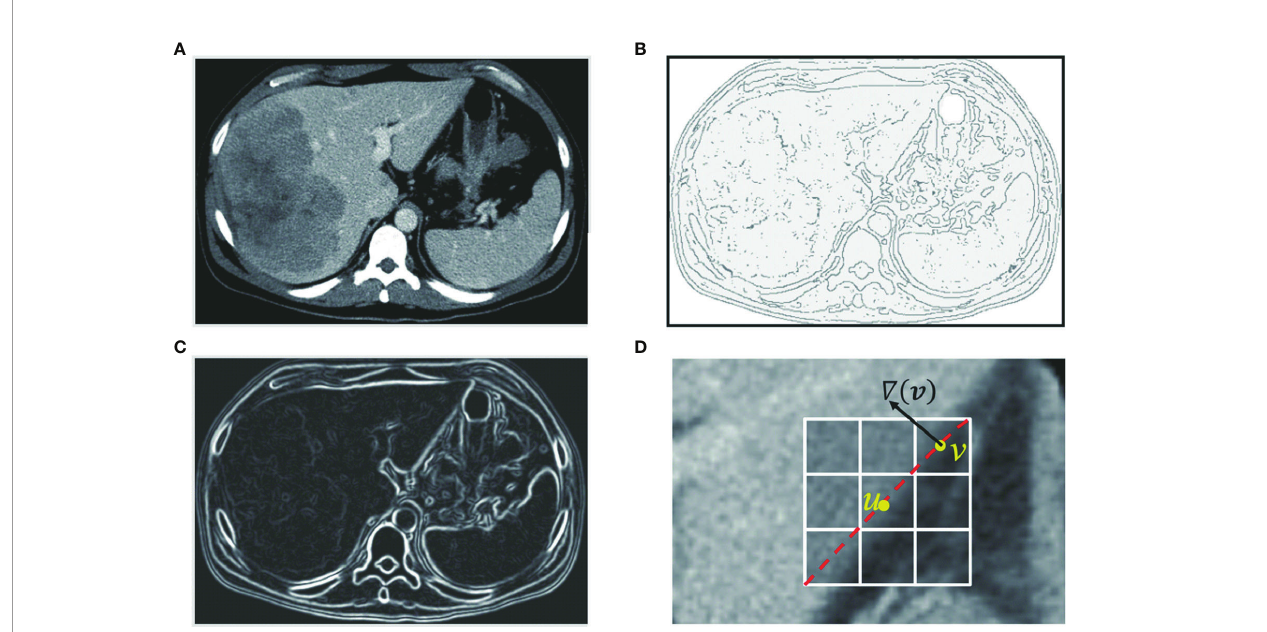
FIGURE 3 | Edge features such as zero-crossing and gradient are incorporated into the computation of local cost. (A) Original axial image. (B) Zero-crossing: points with local maximal gradient magnitude corresponds to a local boundary point with lower cost. (C) Gradient magnitude: a point with a large gradient magnitude tends to indicate a local boundary and thus a lower cost. (D) Gradient direction: a local boundary is perpendicular to the gradient direction. Cost is low if the direction of a link (uv) is perpendicular to the gradient direction [ ▽ ( v )] of the pixel.